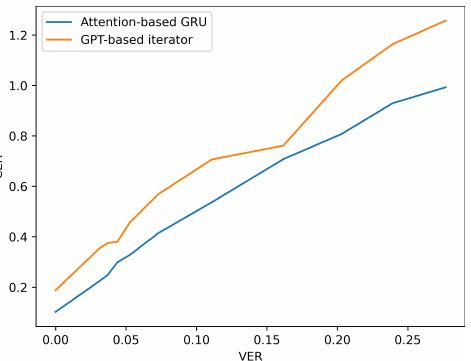
Figure 12. CER performance under varying noise levels (evaluation on LRS3 corpus).